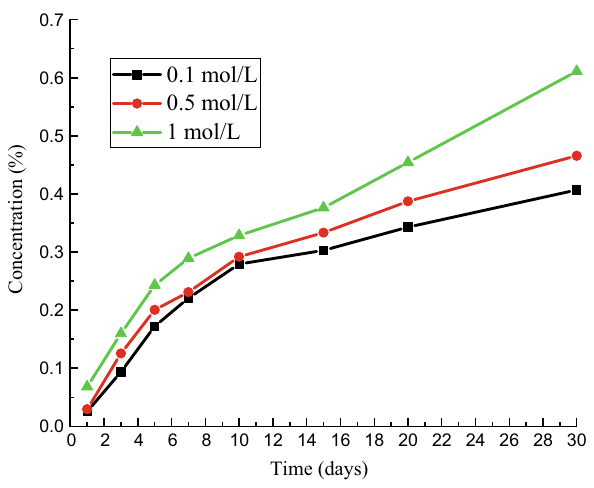
Fig. 4 Concentration development as a function of time at the dis-